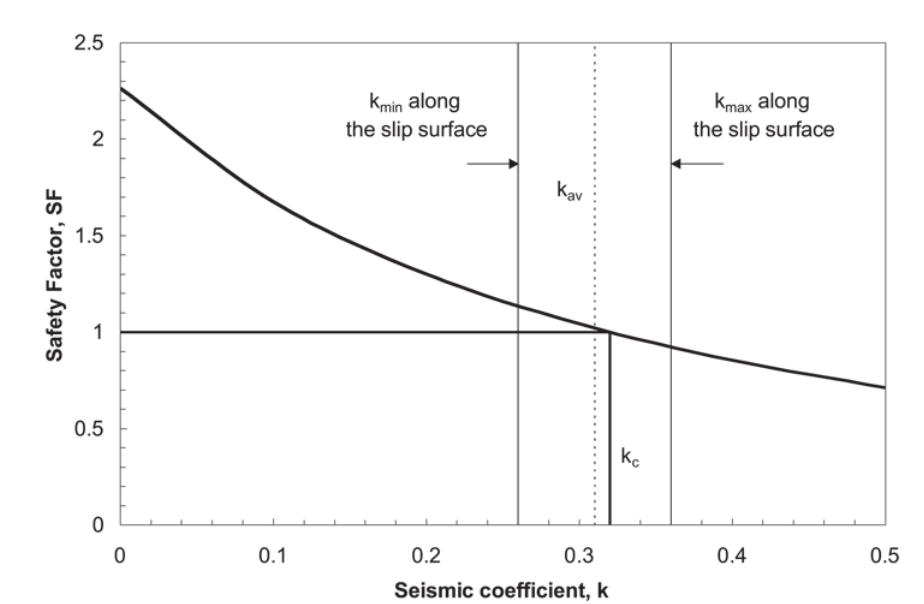
Fig. 8. Pseudostatic safety factor variation with increasing seismic coefficient along the sliding